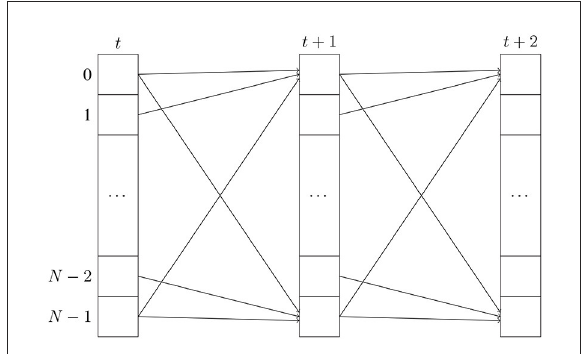
FIGURE3 The dependency pattern for one third of a half-step of the PDE across the last axis of the array. Each column represents an array of length N indexed from 0 to N − 1 for a given timestep. The element at index i of the array at time t + 1 depends on the elements at indices i , ( i − 1) mod N and ( i + 1) mod N of the array at time t .